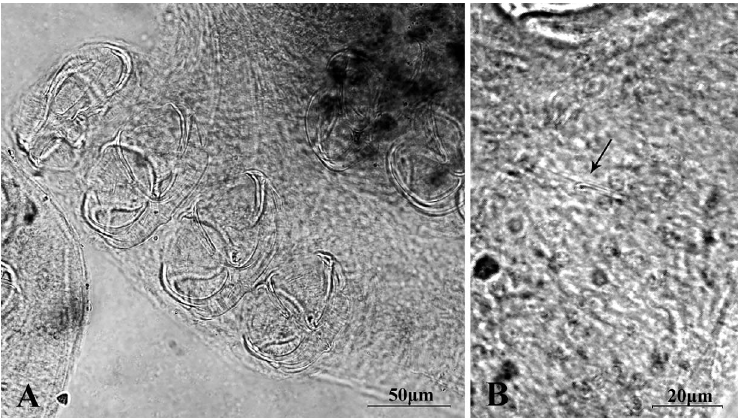
Figure 2. (A) Opisthaptors with four pairs of clamps and (B) a pair of central